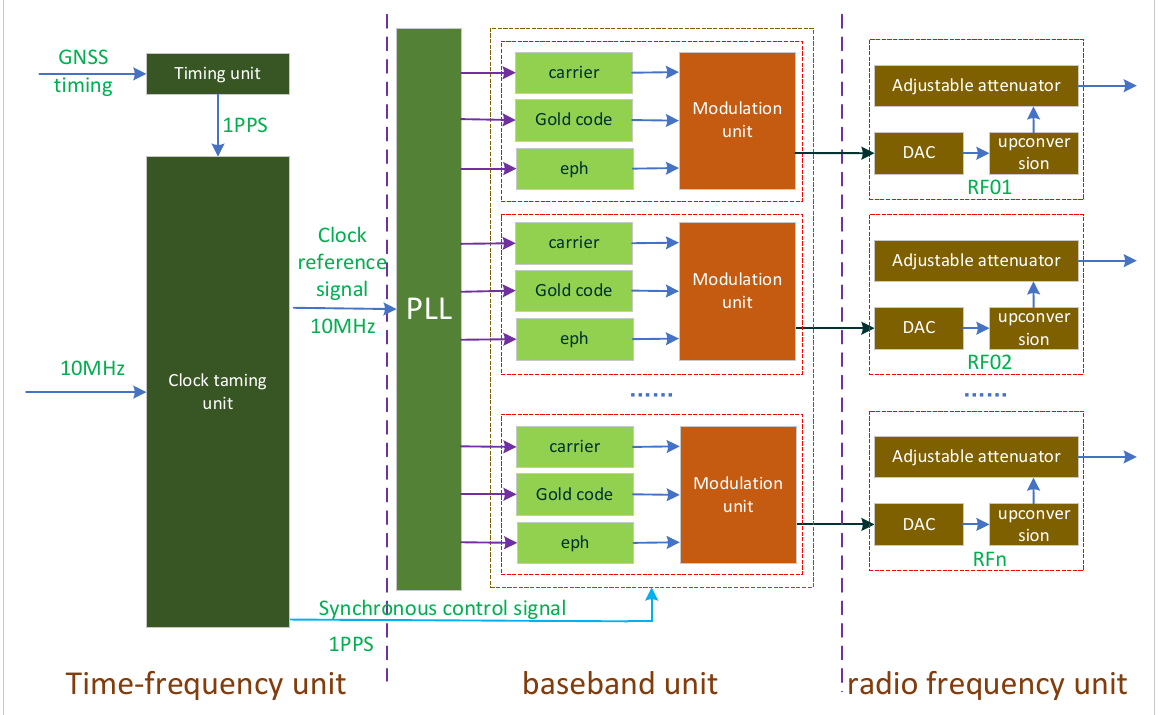
Figure 1. Principle of BDAPS signal generation.